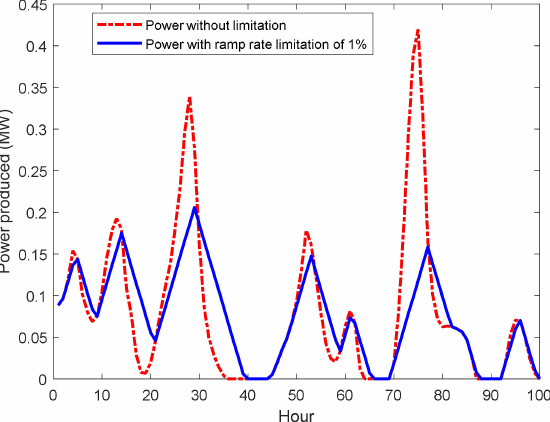
Figure 5. One hundred hour power profile sample with and without ramp-rate limitation.